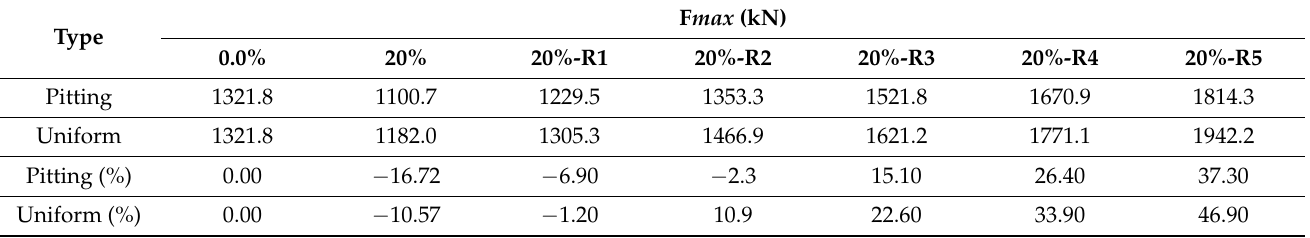
Table 5. Peak force of a bridge pier with 20% corrosion under different thicknesses of steel